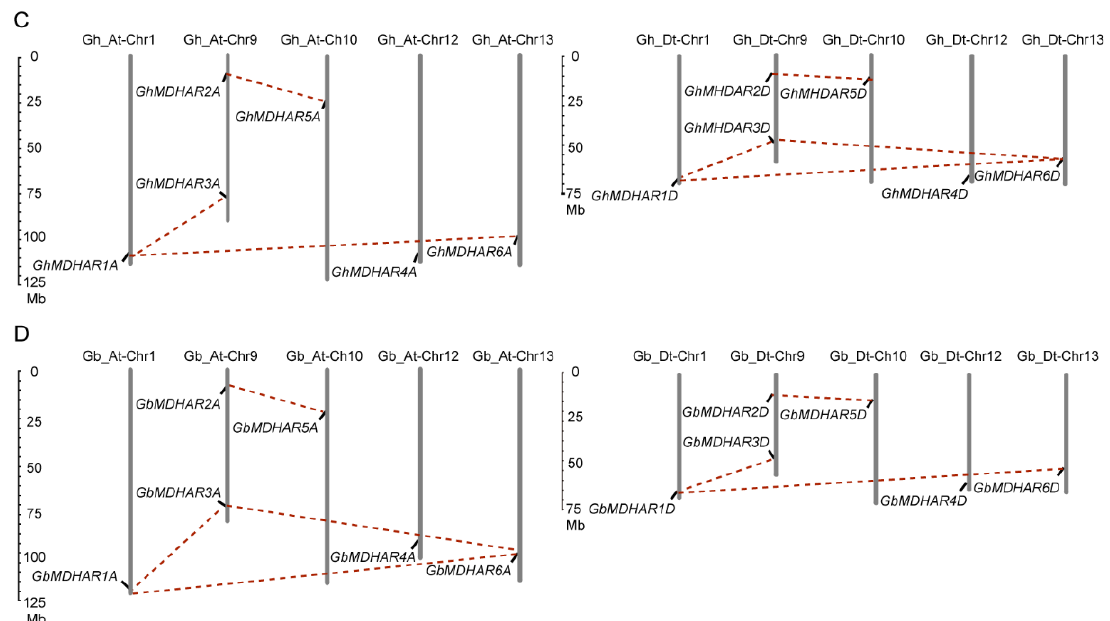
Figure 1. Chromosome distribution of MDHAR family genes in four Gossypium species. The chromosomal mapping of the MDHAR genes of A and D genome in diploid cotton of G. arboreum ( A ) and G. raimondii ( B ), and of A- and D subgenome in allotetraploid cotton of G. hirsutum ( C ) and G. barbadense ( D ), were illustrated. The red dashed lines indicate the segmentally duplicated gene pairs.